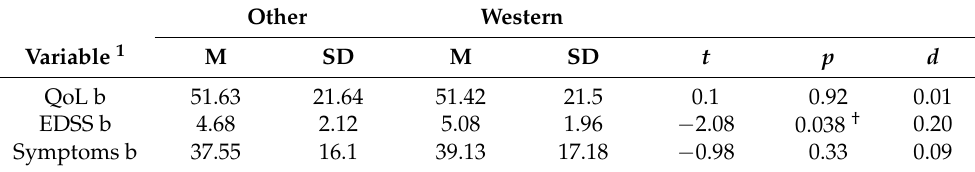
Table 8. Two-tailed independent samples t -test for outcome variables by Western Pattern Diet (WPD).